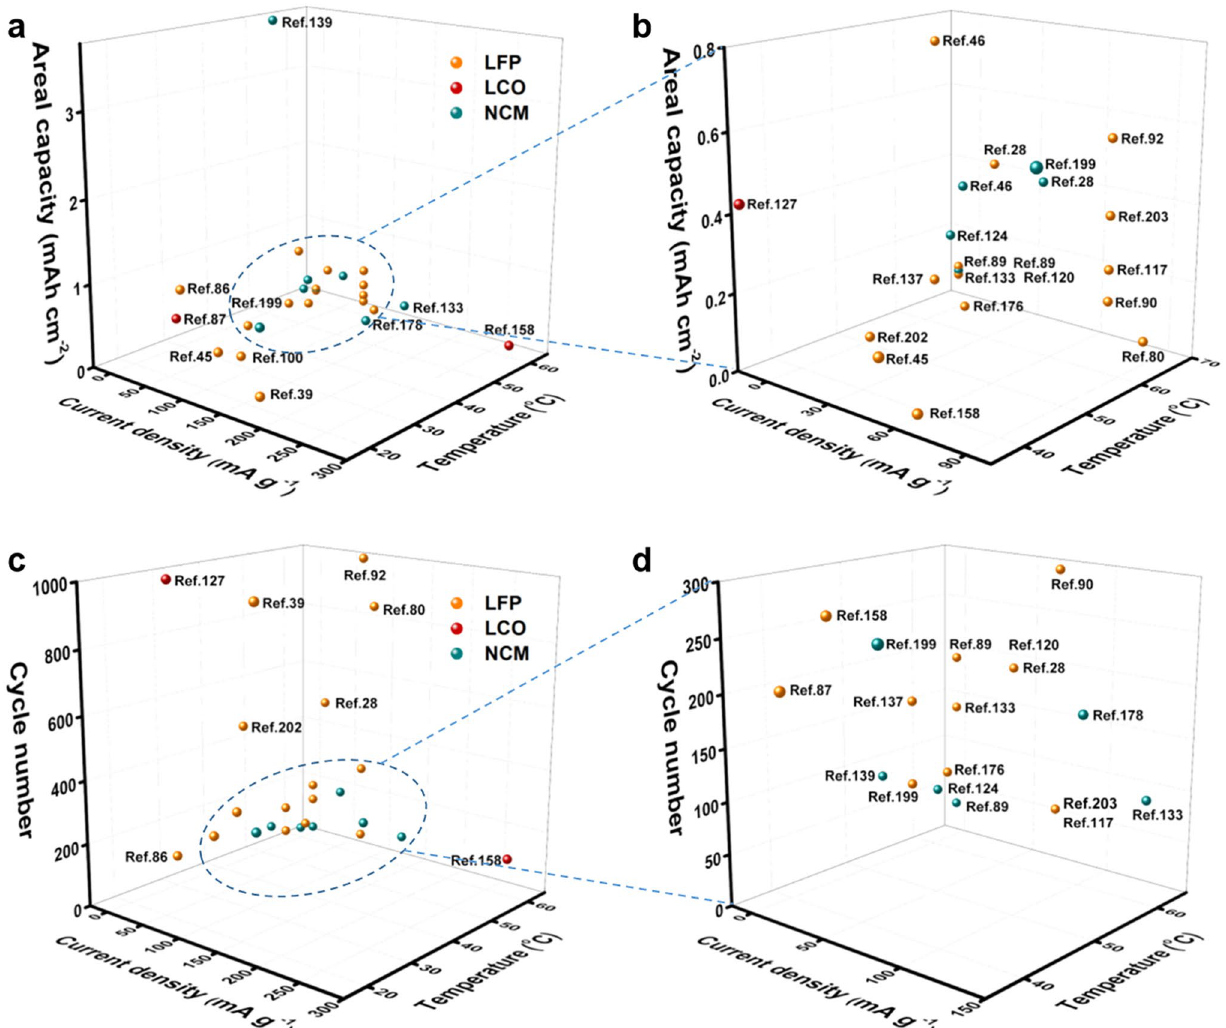
Fig. 12 The comparison of a , b areal capacity and c , d long cycles of lithium metal batteries at different current densities and